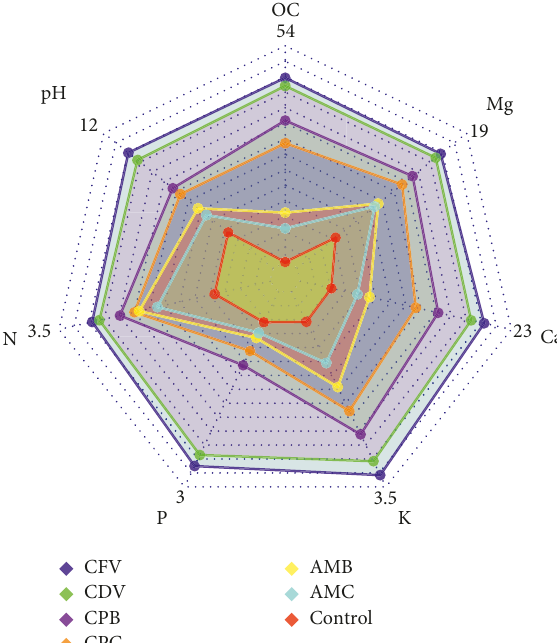
Figure 2: Radar plot for soil properties of different organic